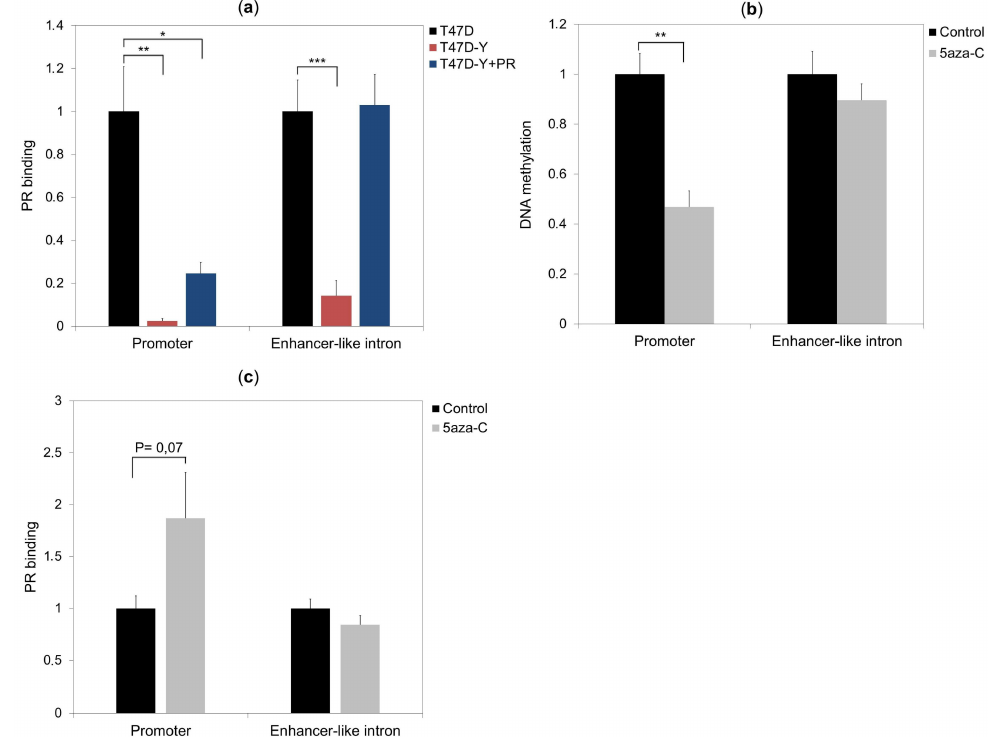
Figure 5. DNA methylation affects PR binding to the ESR1 promoter. ( a ) The high-methylated ESR1 promoter, in contrast to the low-methylated intronic sequence, was only partially bound by PR in PR-rescued cells (T47D-Y + PR). ChIP assays were performed with a specific antibody against PR. Specific binding was assessed by quantitative PCR amplification of the ESR1 gene promoter and an enhancer-like intronic sequence in T47D control cells, PR-deficient cells (T47D-Y) and PR-rescued cells (T47D-Y + PR). Error bars represent the SD of three independent experiments. * p less than or equal to 0.05, ** p less than or equal to 0.01, *** p less than or equal to 0.005, unpaired two-tailed Student’s t -test. ( b ) The 5-azacytidine (5-azaC) demethylated ESR1 promoter. DNA methylation analysis was performed by the MeDIP-qPCR assay using T47D-Y + PR cells treated with the demethylating agent 5-azaC (5 µ M) or vehicle (control). The results are represented as fold change relative to the control. Error bars represent the SD of three independent experiments. ** p less than or equal to 0.01. ( c ) The demethylating agent 5-azaC increases PR binding at the ESR1 promoter in PR-rescued cells (T47D-Y + PR). ChIP was performed as in (b) using T47D-Y + PR cells treated for 112 h with the demethylating agent 5-azaC (5 µ M) or vehicle (control). Error bars represent the SD of three independent experiments. p = 0.07, unpaired two-tailed Student’s t